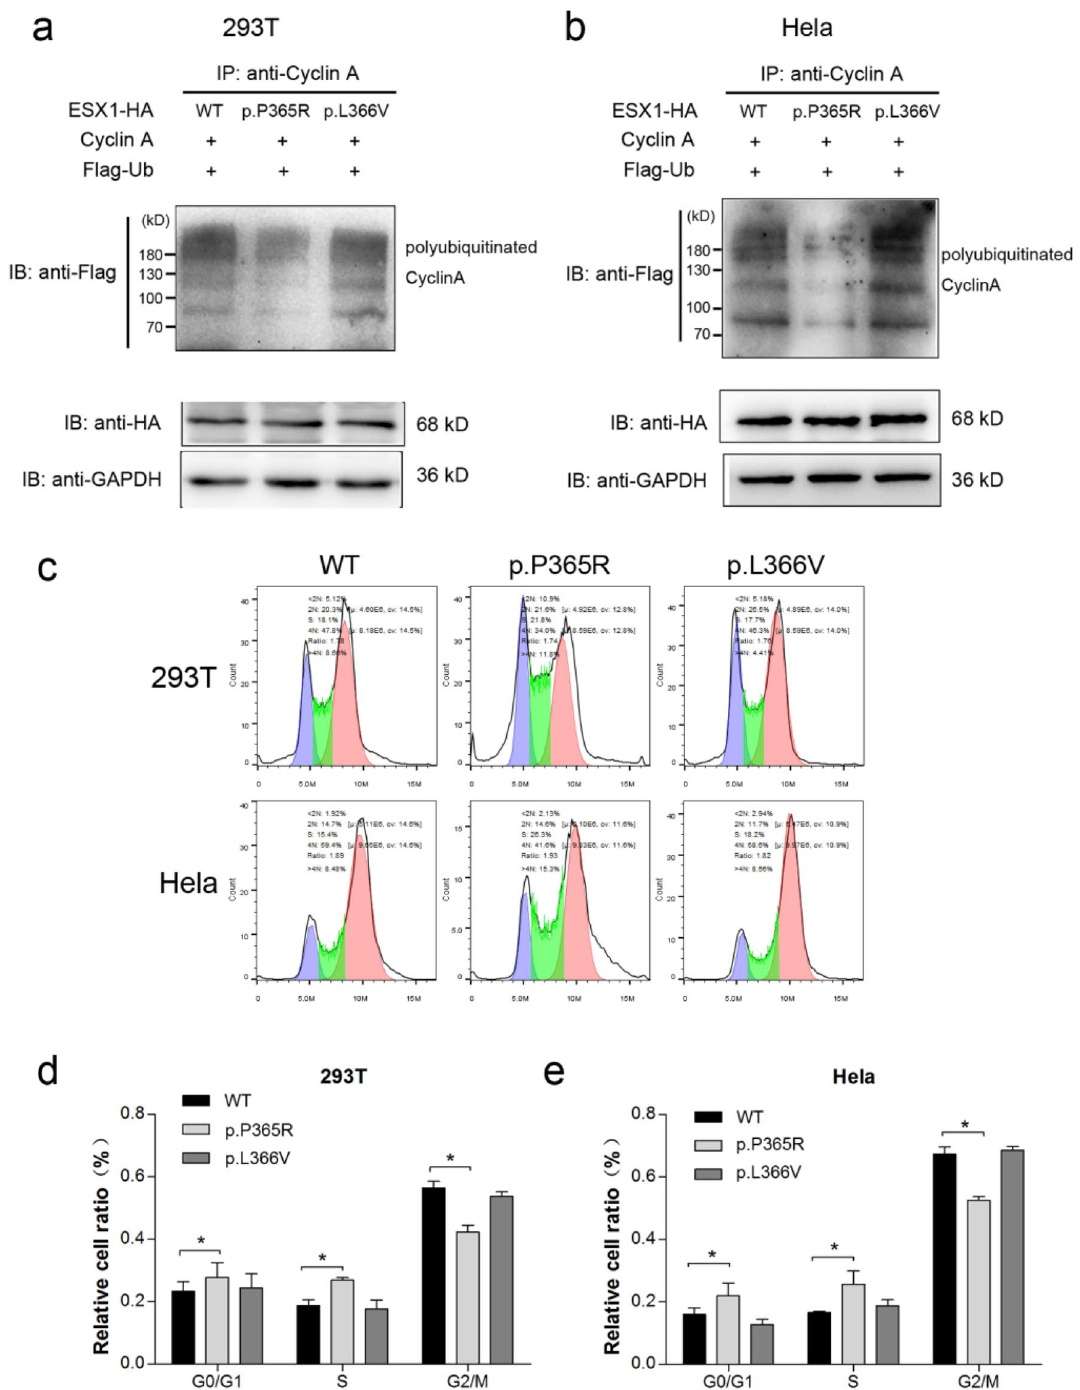
Figure 4. The p.P365R but not p.L366V mutation attributes to the deleterious effect on ESX1 function. p.P365R or p.L366V ESX1 overexpression plasmids were transfected into 293 T and Hela cells as indicated. Wild type ESX1 was used as control. After synchronization as described above, cells were either lysed for IP to detect the polyubiquitination of cyclin A ( a and b ), or subjected to flow cytometry ( c ). Relative cell ratio of different phases in 293 T ( d ) and Hela ( e ) were analyzed statistically using GraphPad Prism 5 software. The grouping of blots cropped from different parts of the same gel, or from different gels, fields, or exposures were divided by black lines. Compared with wild type ESX1, p.P365R but not p.L366V failed to stabilize polyubiquitinated cyclin A, and further lost the ability to arrest cells at M phase. * P <